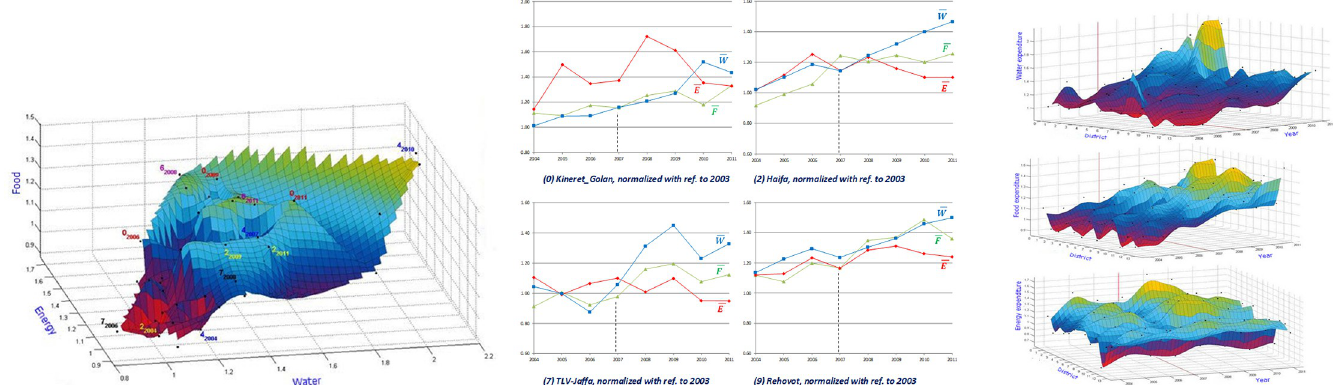
Fig 7. a. Interpolated surface of normalized W ; F and E expenditure locus points for Israels’ 14 districts along the continuous years 2004–2011. Note samples of districts’ evolution path. Districts enumerations are as in Fig 3. Surface was computed with Matlab [72]. b. Snapshots from the W-F-E surface in Fig 7A, of the normalized components’ evolution trend for four different districts. District labels and their enumerations are as in Fig 3. c. Evolution interpolated surfaces of districts’ W, F and E, expenditures, in an enumeration order (Fig 3) from North to South. Note the increase across districts after year 2007. Surfaces were computed with Matlab